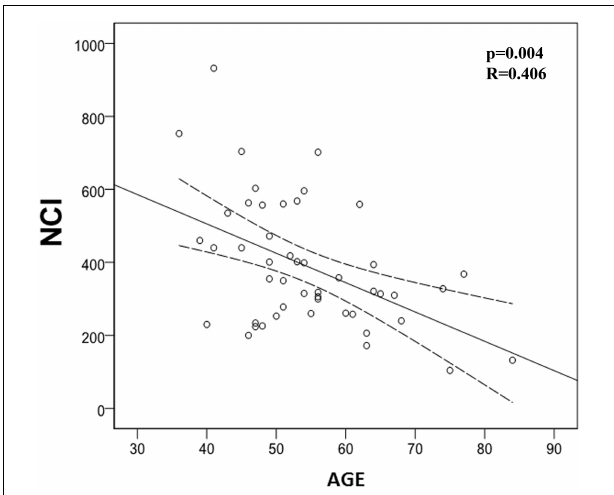
FIGURE 5 | Correlation between Neutrophil Chemotaxis Index (NCI) and age. There is a significant negative correlation between NCI and age ( p = 0.004; R = -0.406).